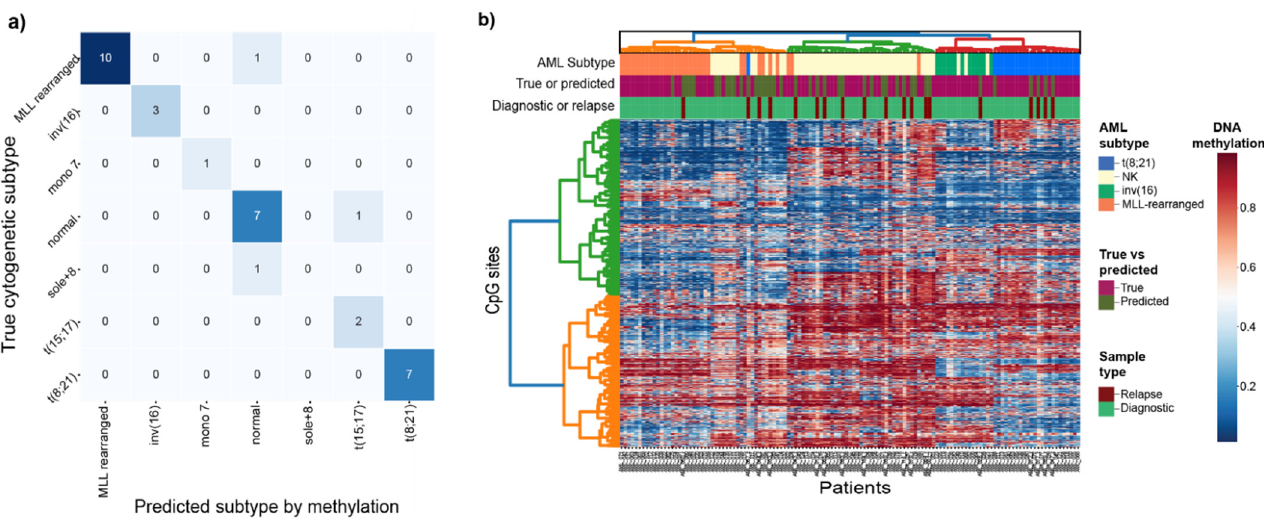
Figure 2. ( a ) Confusion matrix for the cytogenetically defined (diagnostic-known) vs. DNA methylation predicted cytogenetic subtypes (N = 33). ( b ) Heatmap and hierarchical clustering of 127 samples taken at AML diagnosis or relapse from patients belonging to the four subtypes most common subtypes; t(8;21)/ RUNX1-RUNX1T1 , inv(16)/ CBFB-MYH11 , MLL/KMT2A -rearranged and NK. The methylation status of the selected 1300 CpG sites are plotted in the heatmap. The samples are in columns labeled by AML subtype, whether the sample was cytogenetically defined (true/diagnostic-known) or cytogenetically undefined (DNA methylation predicted), and if the sample was taken at AML diagnosis or relapse. Table 2. Precision, recall, F1 scores per subtype, as well as overall accuracy of the classifier for the four subtypes with >5 patients in the group. High precision scores indicate the low number of false positives (FP) while high recall scores the low number of false negatives (FN). Total samples Total Samples Precision Recall F1 Score Test Set